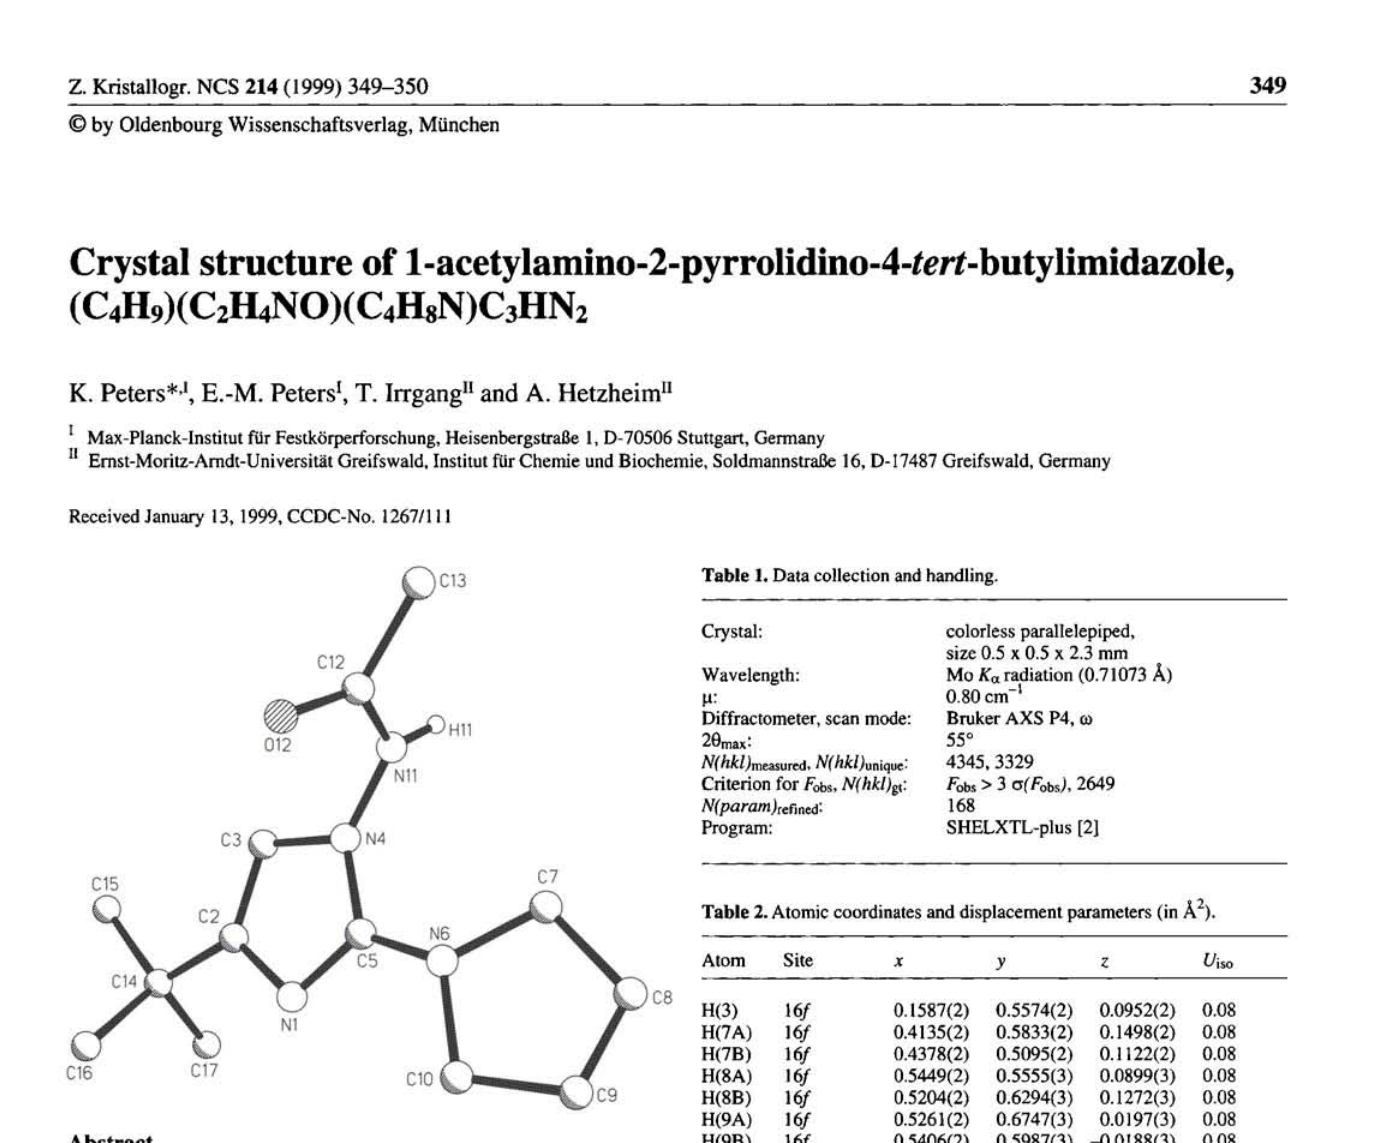
Table 2. Atomic coordinates and displacement parameters (in Â ).